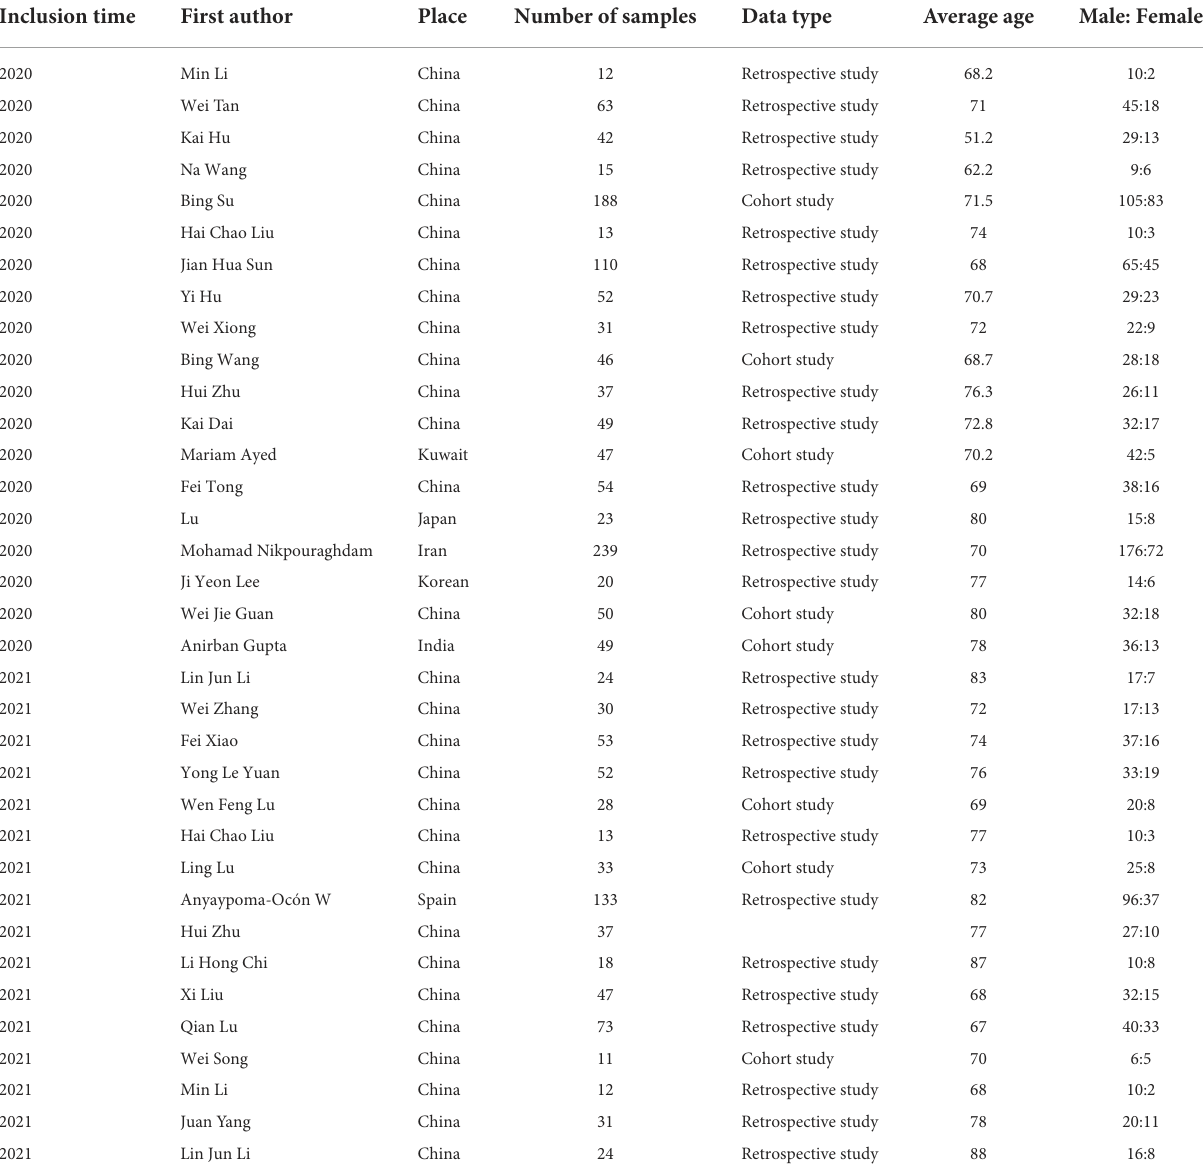
TABLE 1 Basic information of included